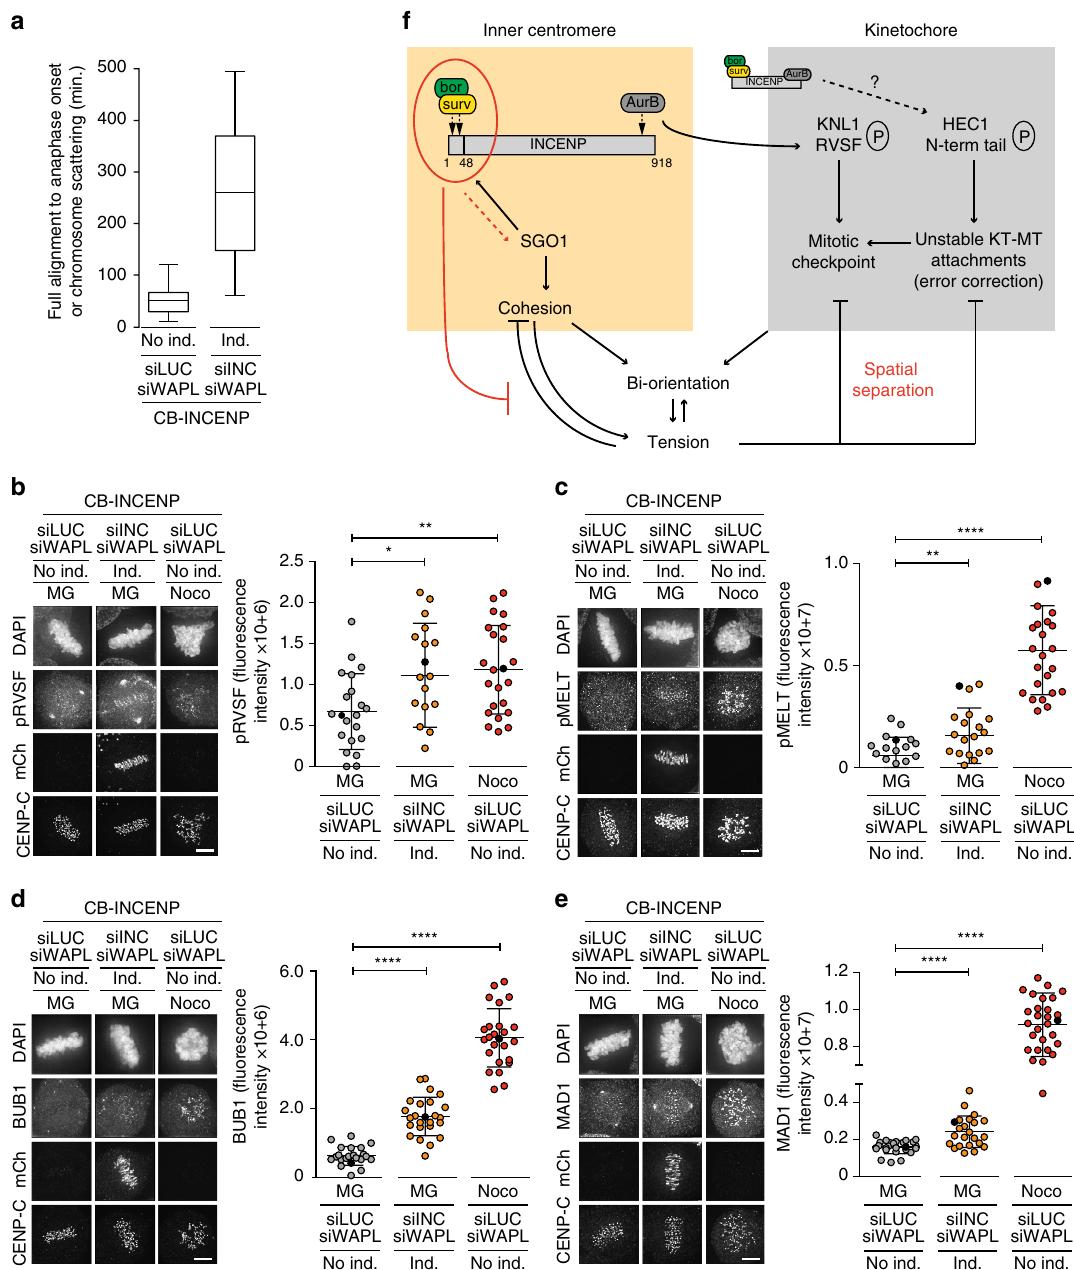
Figure 5 | Spatial separation of Aurora B from KNL1 coordinates mitotic checkpoint silencing with bi-orientation. ( a ) Time in metaphase for WAPL- and/or INCENP depleted cells ± CB-INCENP ( n ¼ Z 21 cells, see also Supplementary Fig. 4a–d). ( b – e ) IF of mCherry, CENP-C and KNL1-pRVSF-S60 (pRVSF) ( b ), KNL1-pMELT-T601 (pMELT) ( c ), BUB1 ( d ) and MAD1 ( e ) in cells ± induction of CB-INCENP, transfected with indicated siRNAs and subjected to the bi-orientation assay. Quantifications of fluorescence intensities are shown on the right side of each panel (1 out of 2 exp., n ¼ Z 18 cells per condition, bars: mean ± s.d., * P o 0.05; ** P o 0.01; **** P o 0.0001; unpaired t test, spindle poles were excluded from the quantifications). The corresponding data points of the images (scale bars, 5 m m) are coloured black in the graphs. ( f ) Model for how the CPC regulates the inner centromere and kinetochore to allow the build-up of tension upon bi-orientation, to counteract cohesion fatigue upon bi-orientation and tension, and to coordinate mitotic checkpoint silencing with chromosome